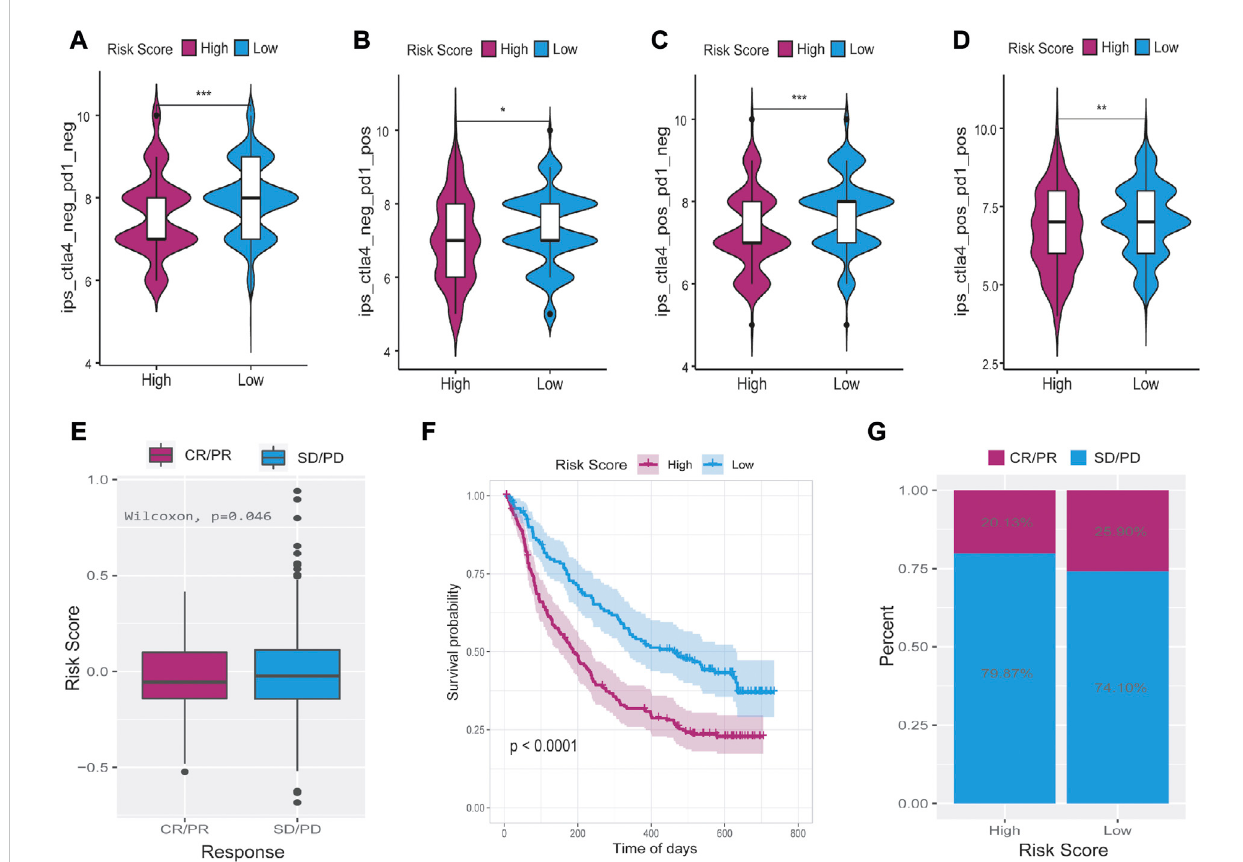
FIGURE 11 The relationship between tumor risk score and the response of immunotherapy. (A – D) Immunophenoscore was signi fi cantly higher in the low-risk group than in the high-risk score group. (E – G) Low-risk score patients who received anti-PD-L1 treatment had better responses to immunotherapy